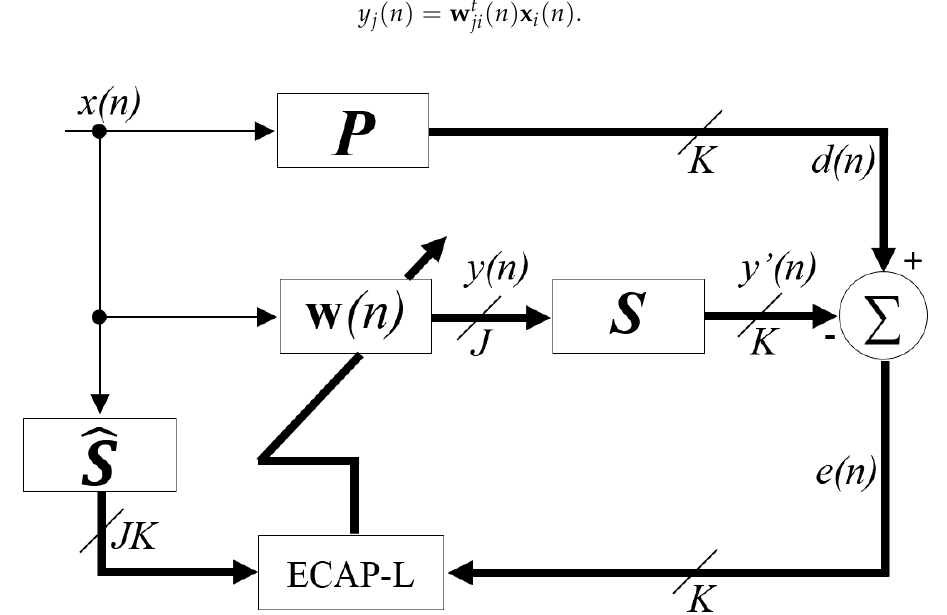
Figure 1. Block diagram of the FXECAP-L algorithm for active noise